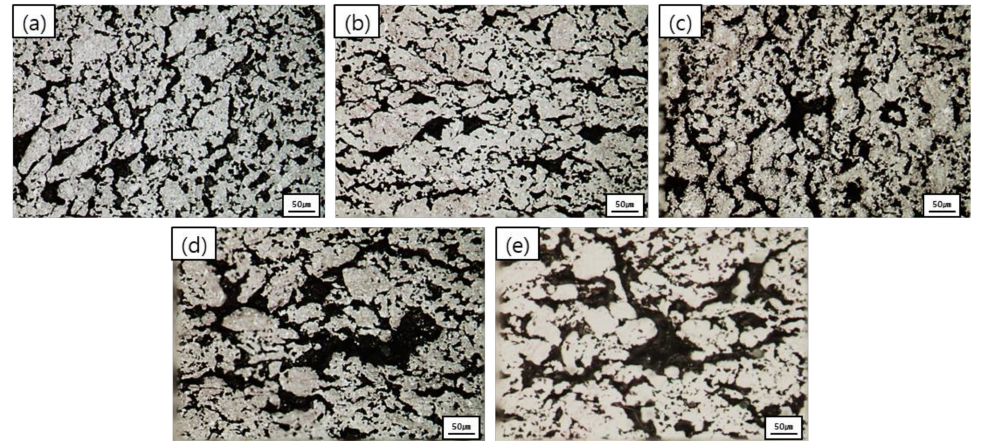
Figure 4. Microstructure of graphite blocks as a function of heating rate ( × 200) ( a ) 1 ◦ C/min, ( b ) 3 ◦ C/min, ( c ) 5 ◦ C/min, ( d ) 7 ◦ C/min, ( e ) 9 ◦